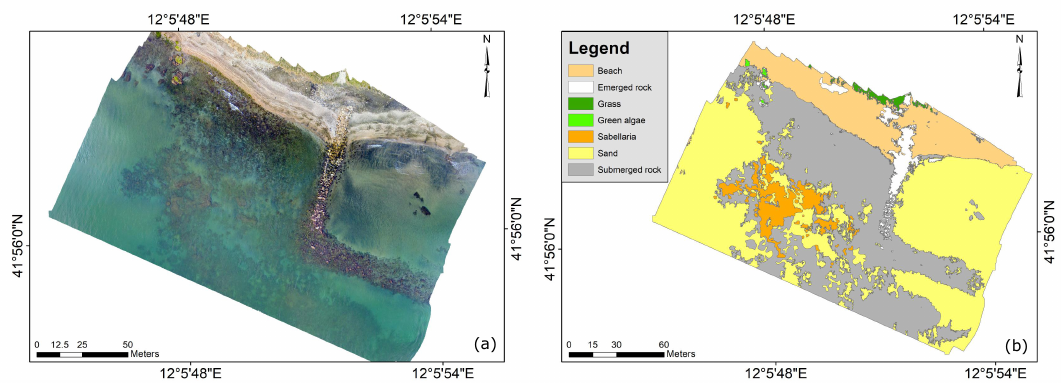
Figure 9. High-resolution orthomosaic of the site S3 ( a ) representing a sandy coast with underwater formation of reef-building tube worm Sabellaria alveolata . Thematic map of the same areas generated after image segmentation and classification through OBIA algorithm ( b ).